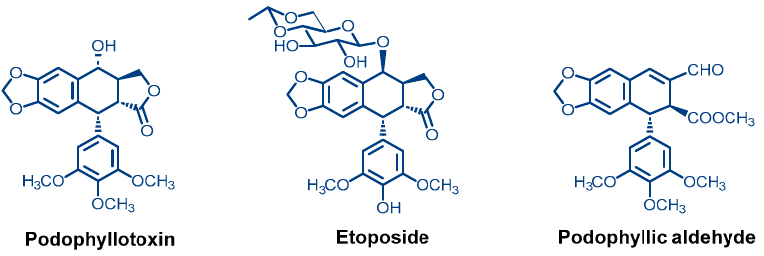
Figure 1. Chemical structures of podophyllotoxin and its derivatives etoposide and podophyllic aldehyde.